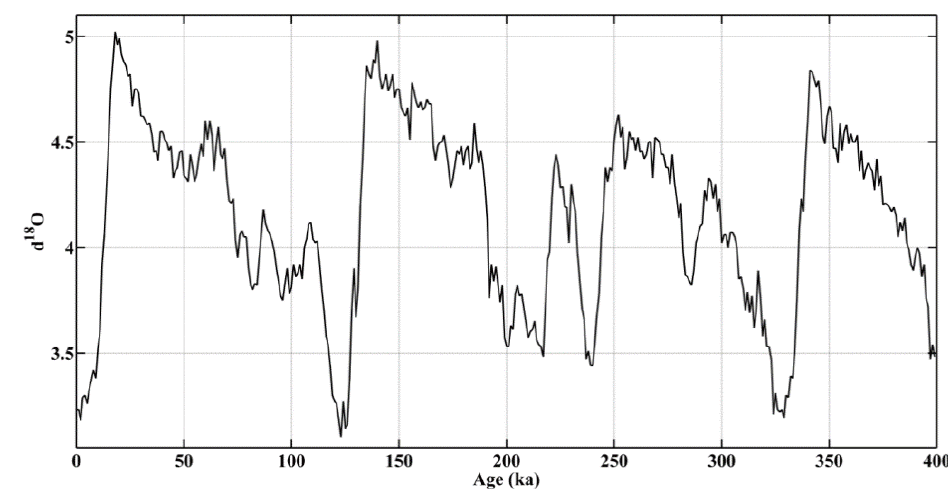
Figure 1. Temporal fluctuations of the isotopic composition of precipitation [17].